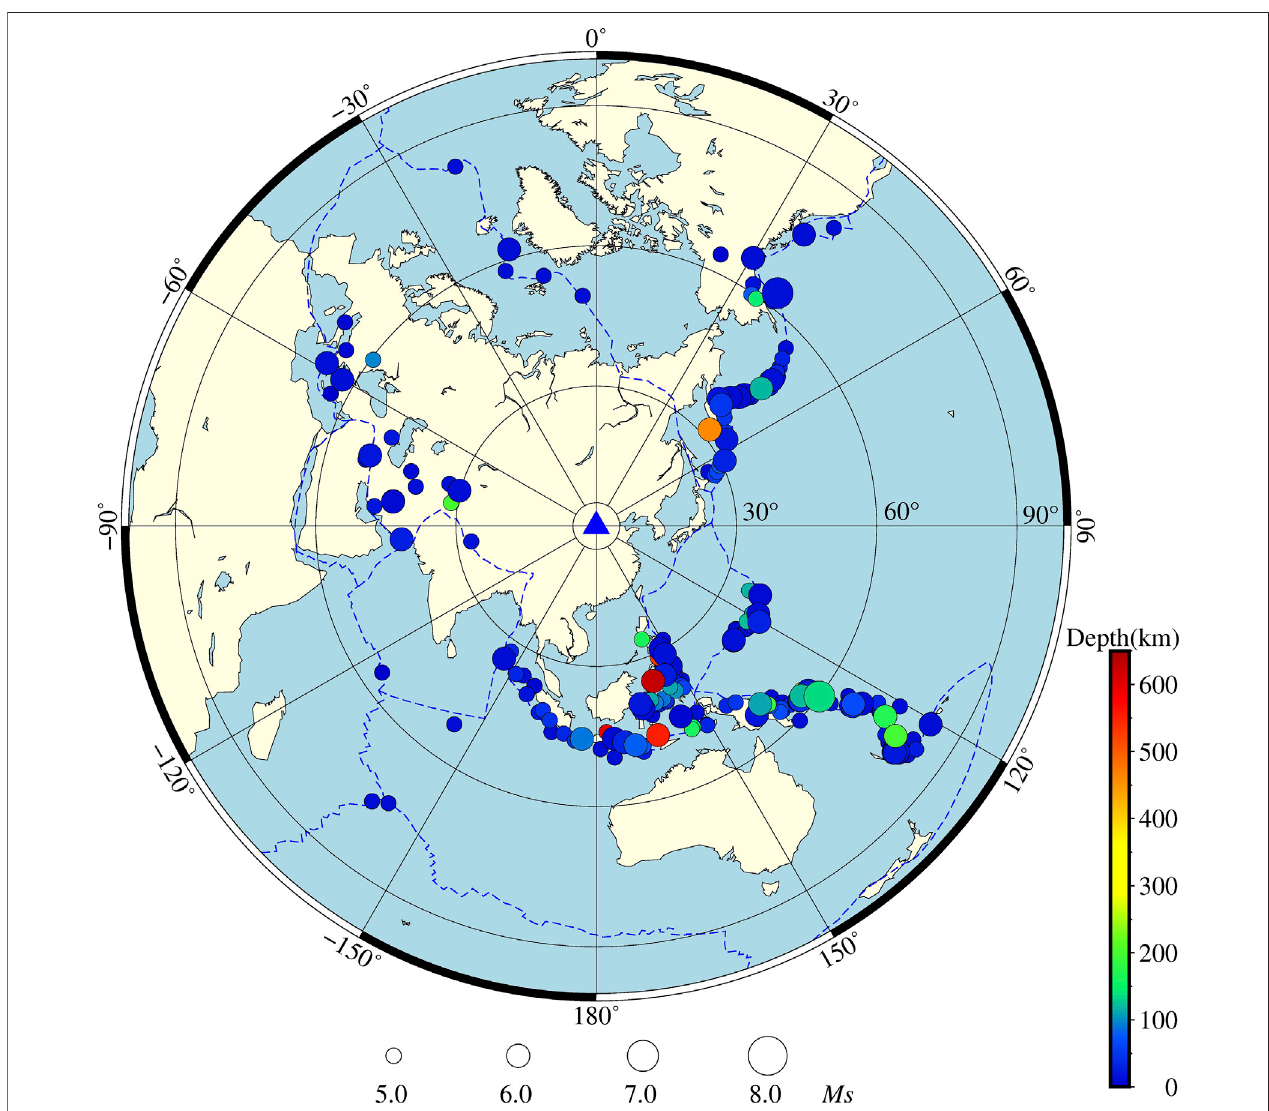
FIGURE 2 | Locations of 280 earthquakes used in this study. The color fi led circles show the epicenters. The size of the circles represents the earthquake magnitude and the color indicates event depth. Note that although some events are located inside the 30 ° circle, all the seismograms we used have an epicentral distance between 30 ° and 85 °